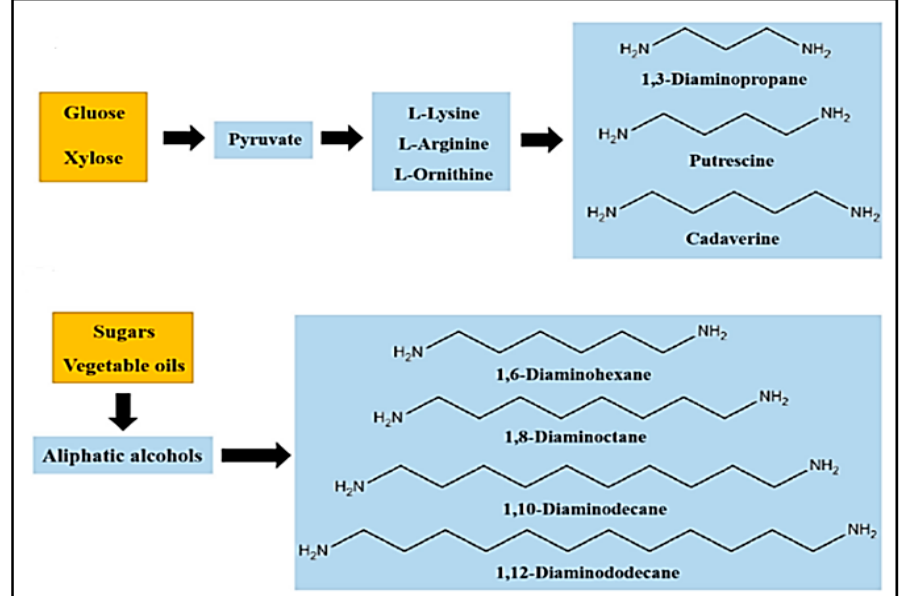
Figure 7. Different methods for preparing bio-based diamines. Reprinted from ref [66] with permis- sion from the publisher.